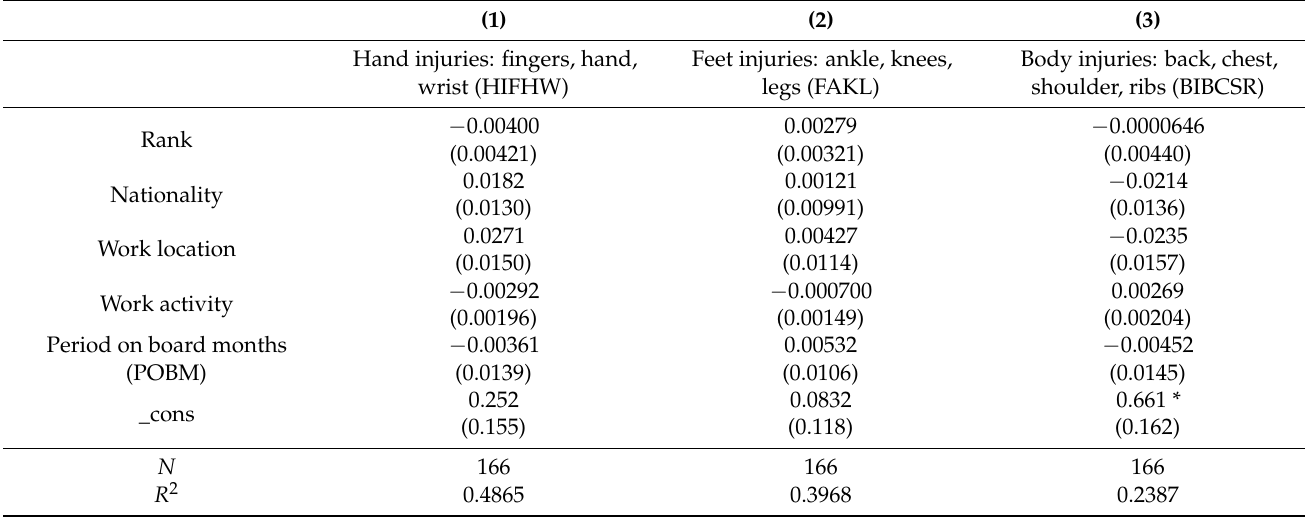
Table 2. Results of panel regression—impact on specific factors.